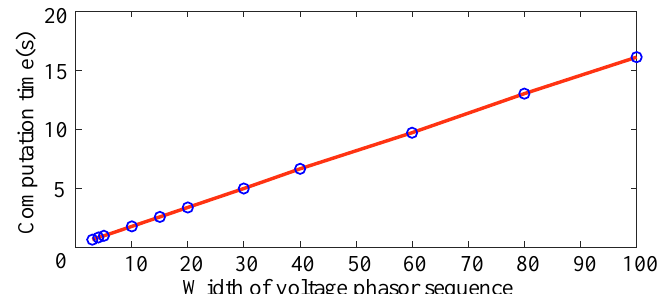
Figure 7. The trend of computation time. Figure 8. The trend of computation